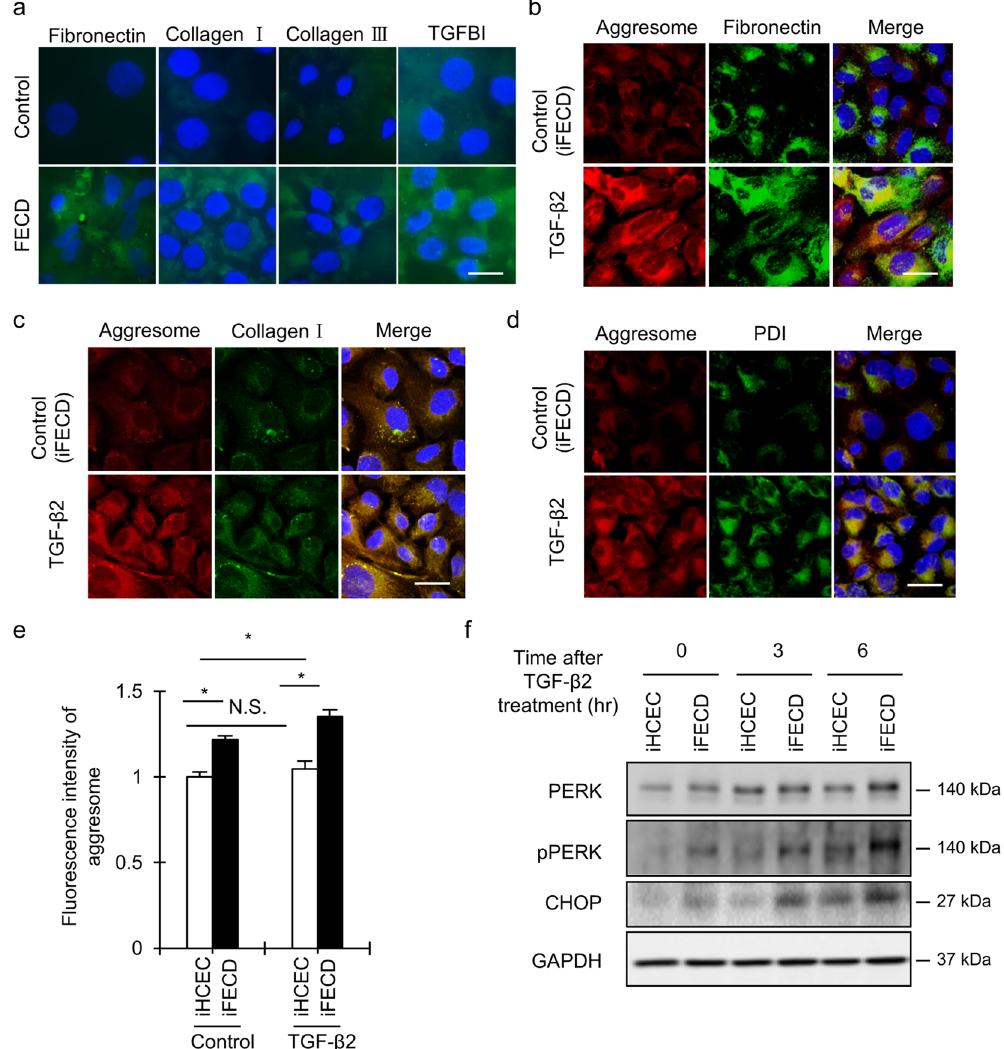
Figure 2. Effect of TGF- β on extracellular matrix (ECM) protein expression and unfolded protein formation. ( a ) Descemet’s membranes including CECs were obtained from 22 patients with FECD during Descemet’s membrane endothelial keratoplasty (DMEK) and were examined for the expression of ECM; fibronectin, collagen type 1, collagen type 3, and TGBI were evaluated by immunofluorescent staining. Human donor corneas from 19 non-FECD subject were used as control. Scale bar: 50 µ m. ( b , c ) iFECD, which is a corneal endothelial cell model established from patients with FECD, were cultured and stimulated with TGF- β 2 for 48 hours. The expression of fibronectin and collagen type 1 was evaluated by immunofluorescence staining. Unfolded protein was assessed by aggresome staining. Nuclei were stained with DAPI. Experiments were performed in triplicate. Scale bar: 50 µ m. ( d ) Immunofluorescent staining of PDI and aggresome staining was performed to evaluate the codistribution of endoplasmic reticulum (ER) and unfolded protein. Nuclei were stained with DAPI. Experiments were performed in triplicate. Scale bar: 50 µ m. ( e ) iFECD and iHCEC were cultured with or without TGF- β 2 (10 ng/ml) for 48 hours. Cells were stained with aggresome and fluorescence intensity was evaluated by flow cytometry. Experiments were performed in triplicate. The statistical analysis was performed by Student’s t-test. * P < 0.01. ( f ) iFECD and iHCEC were cultured with or without TGF- β 2 (10 ng/ ml), and expression of PERK, phosphorylation of PERK, and expression of CHOP was evaluated by western blotting. Experiments were performed in triplicate. GAPDH was used as internal